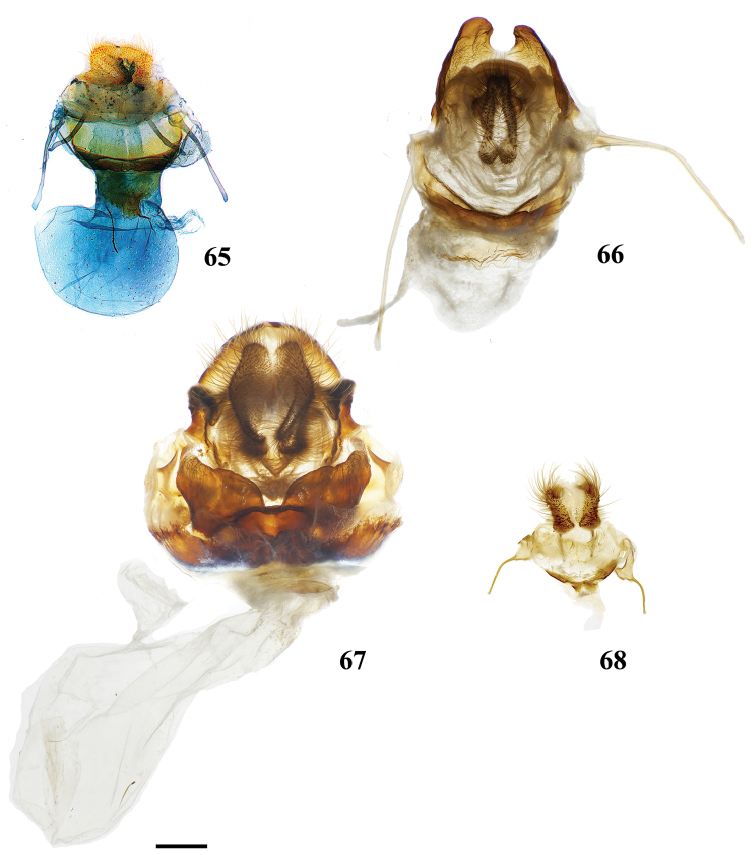
Ventral view of female genitalia of type species (except where noted) of genera belonging to Cicinninae: Psychocampini and Bedosiini. 65Biterolfaalthea, D. Herbin genitalia diss.: H600 [reused with permission from St Laurent et al. (2017d), Tropical Lepidoptera Research] (CDH) 66Psychocampaconcolor, St Laurent diss.: 3-31-18:7 (MGCL) 67Bedosiaturgida, St Laurent diss.: 3-31-18:6, not the type species of Bedosia (MGCL) 68Bedosialloforbesi, St Laurent diss.: genitalia vial NHMUK 010402292 [reused with permission from St Laurent et al. (2018a), Systematic Entomology] (NHMUK). Scale bar: 1 mm.